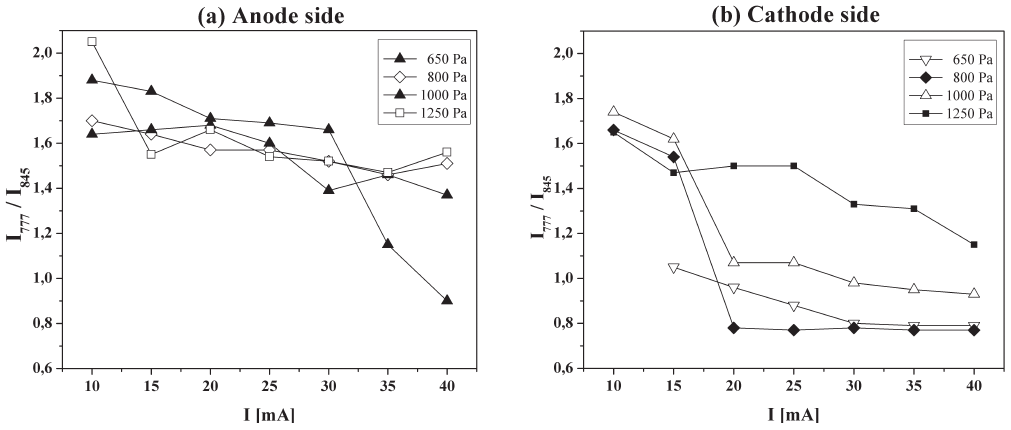
/I determined both on anode (a) and cathode (b) side of the tube with respect to the 777 845